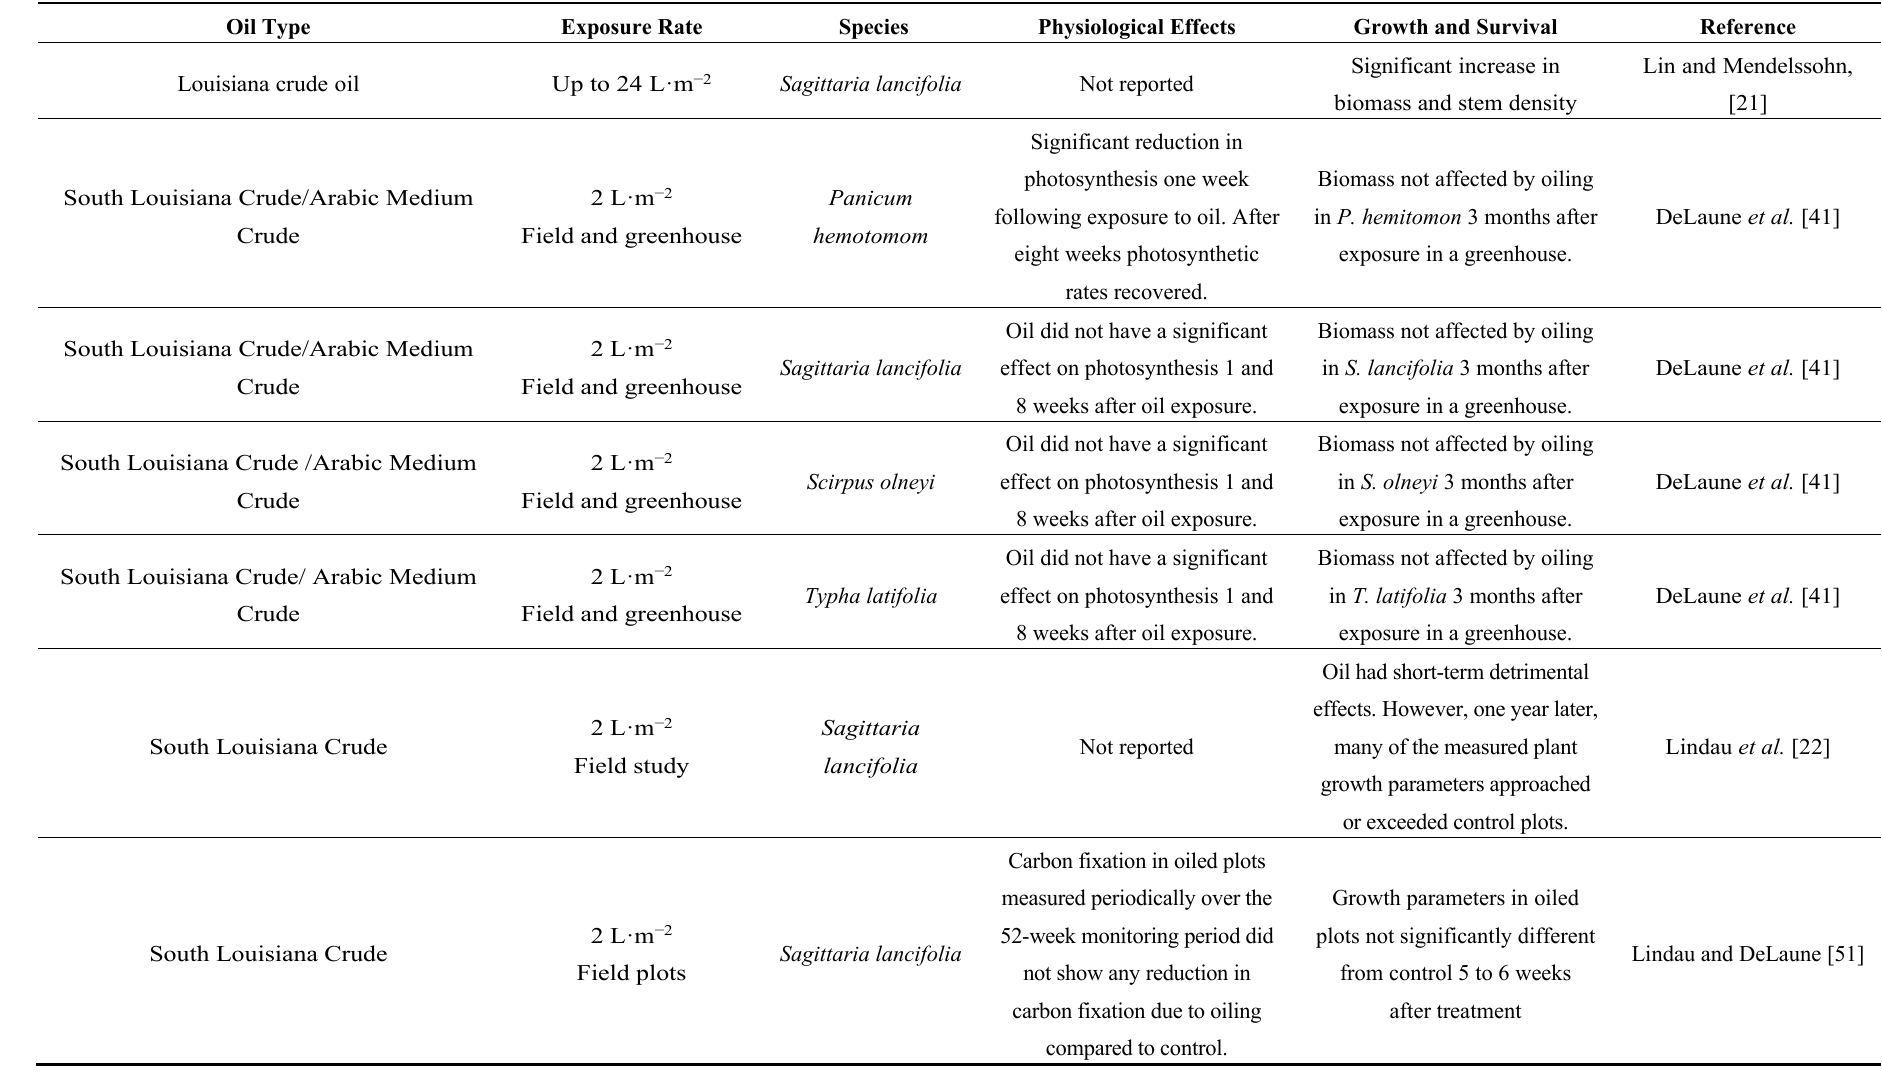
Table 2. Effects of oil on US Gulf coastal freshwater marsh